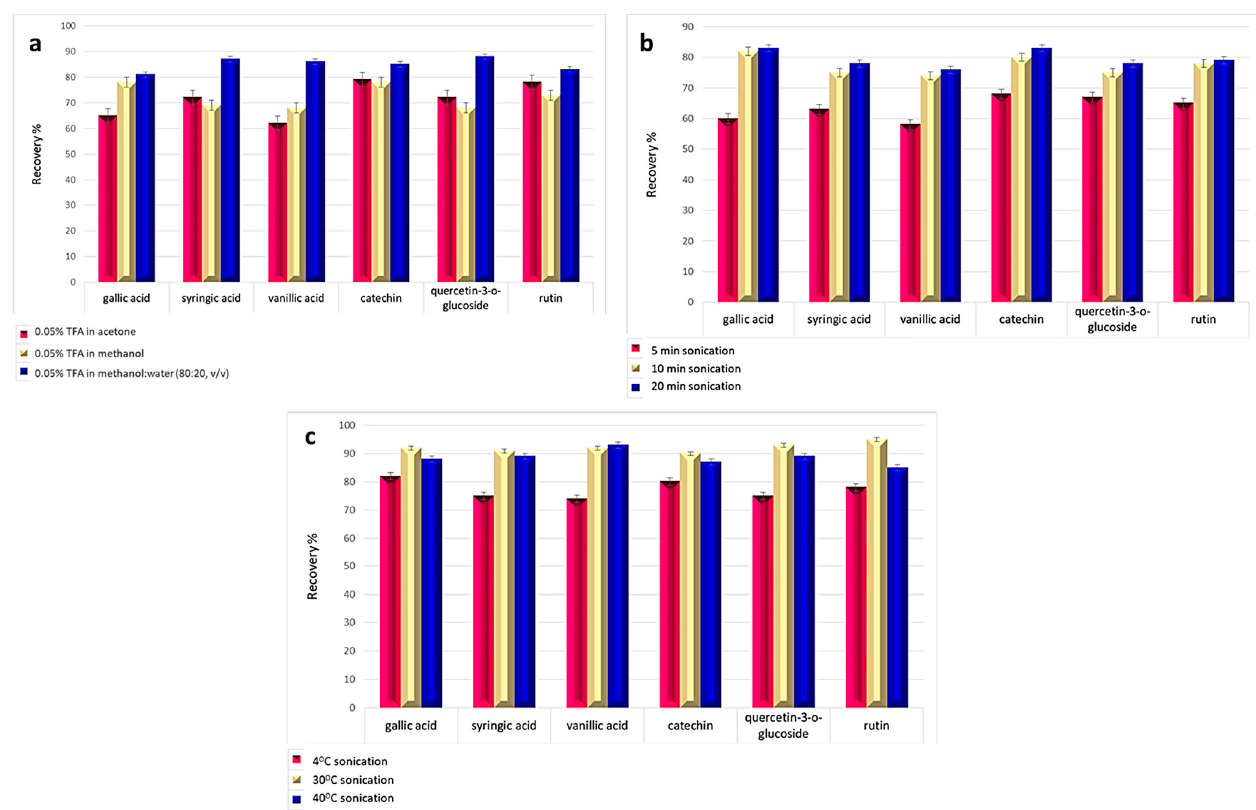
Figure 1. Effect of ( a ) extraction solvent; ( b ) extraction time, ( c ) extraction temperature on the extraction efficiency.